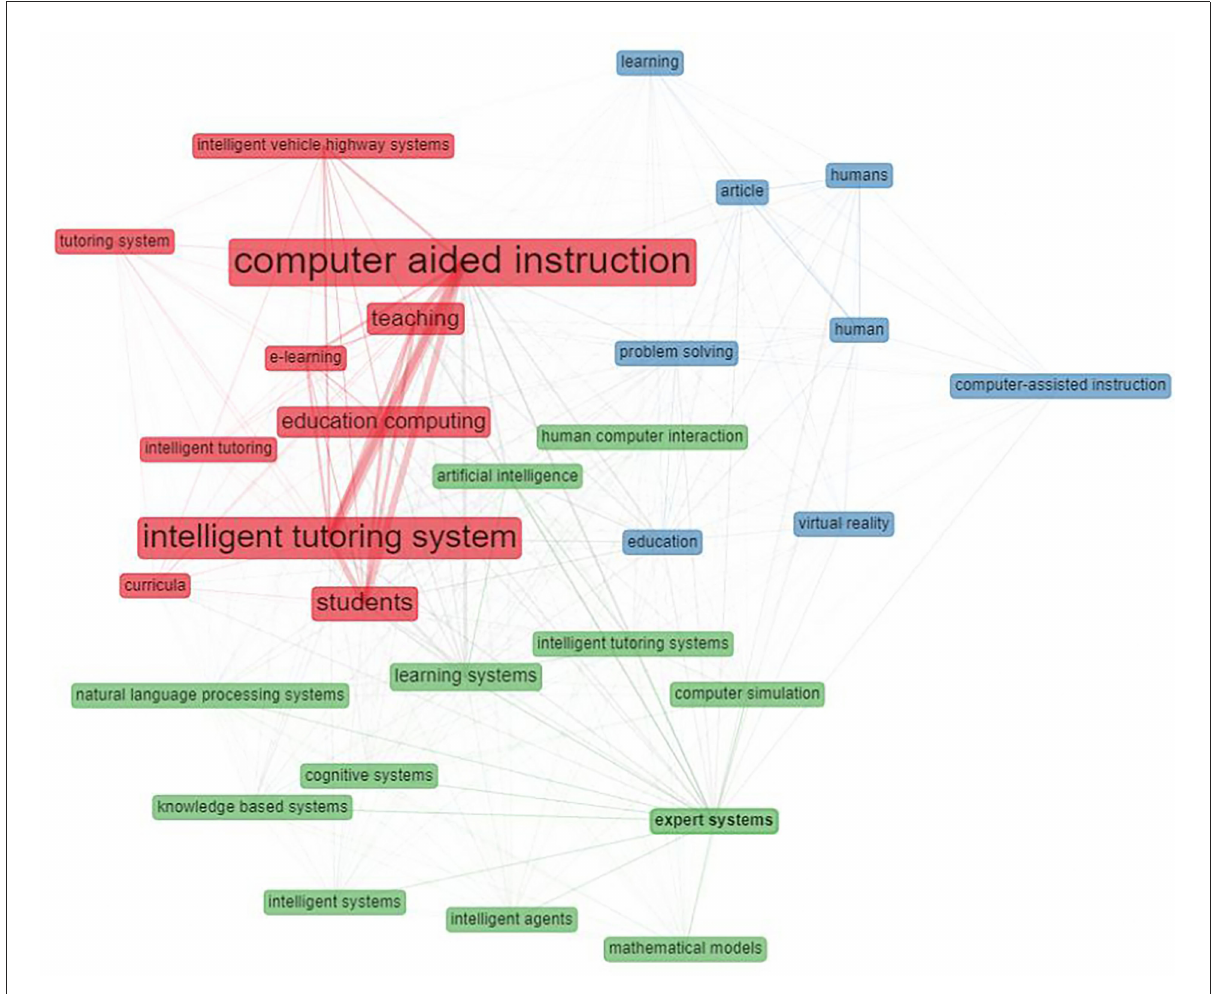
FIGURE5 Co-occurrence of words in Keyword Plus from all